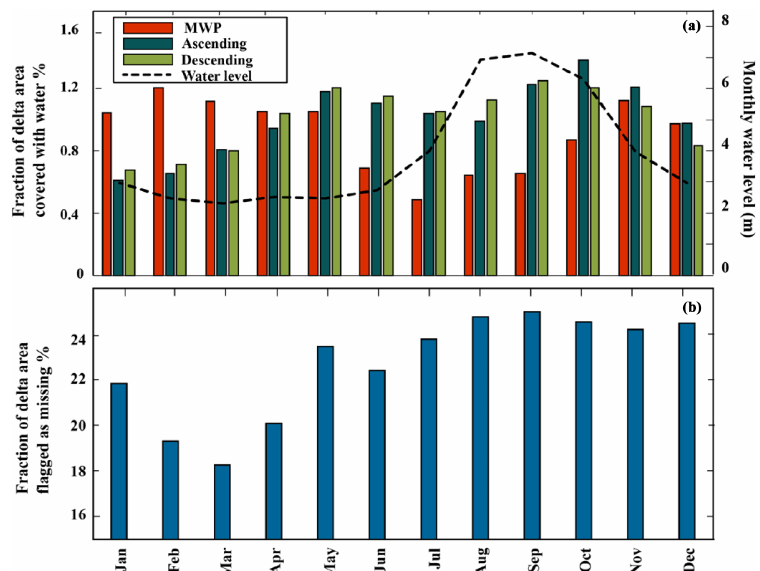
Figure 8. The monthly inundated areas of the Mekong Delta calculated from the proposed retrieval algorithm and MODIS near-real-time (NRT) water product (MWP) data in comparison with ground-based monthly water level data. (a) Comparison of the total inundated surface of the Mekong Delta from MWP products and the retrieval algorithm from ascending and descending dictionaries. From visual inspection, it is obvious that the retrieval algorithm can better follow variations of the water levels compared to MWP. More inundation over the dry season is reported by MWP products than the wet season, which contradicts the causality between rivers’ stages and the extent of inundated areas. (b) The total fraction of land surface areas that are labeled as missing in MWP product because of atmospheric contaminations. The larger deviations of the MWP products from water level data during the wet months might be attributed to the larger percentage of missing values.